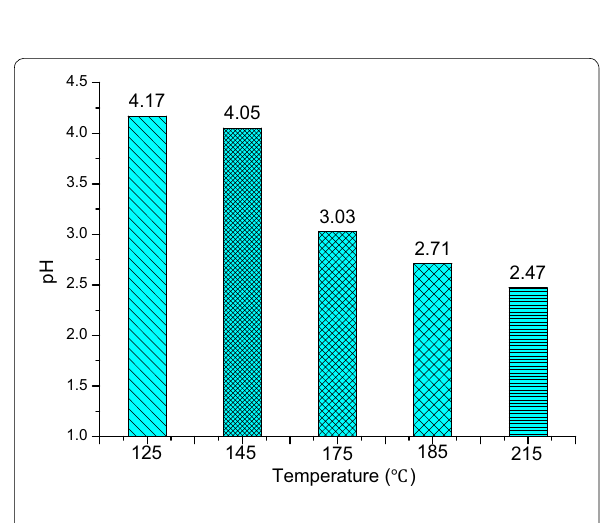
Fig. 4 The pH of the effluents condensated by VOCs of rubberwood from different heat-treatment